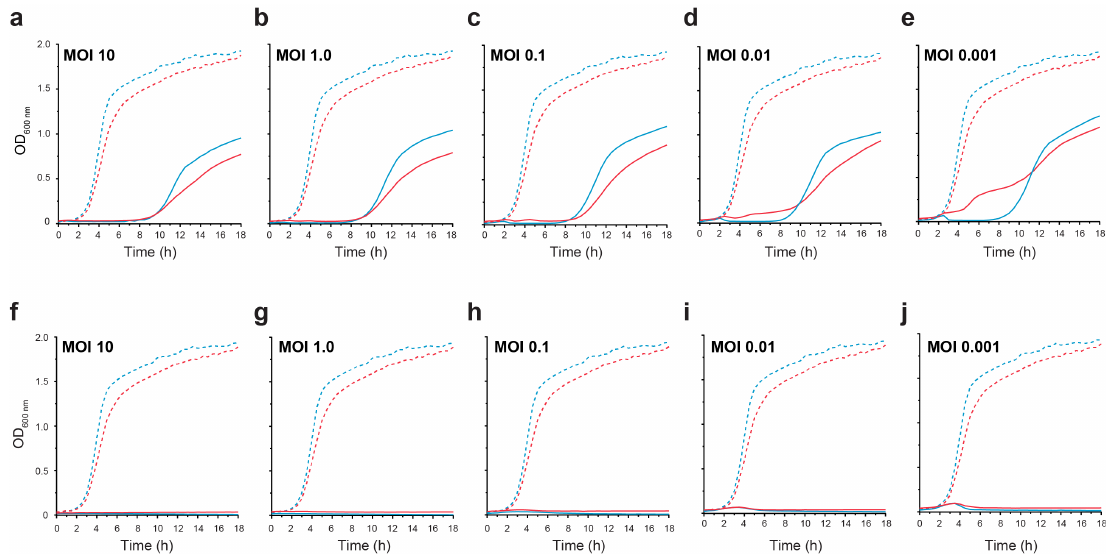
Figure 3. CrRp3 or CrRp10 lysis curves of C. rodentium under normoxic and hypoxic conditions. Growth curves of C. rodentium ICC180 infected with CrRp3 ( a – e ) or CrRp10 ( f – j ) at MOI ranging between 10–0.001 (solid line) or no phage control (dashed line). Bacteria were growth under either 21% (blue line) or 5% (red line) oxygen and 5% CO 2 conditions. N = 6 per condition.